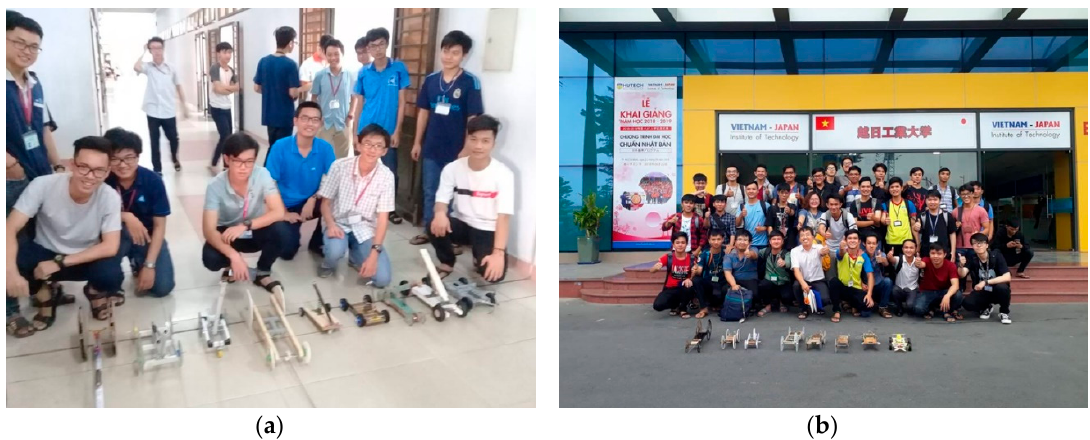
Figure 1. Mini-project of introduction to engineering class: ( a ) at HCMUT, and ( b ) at HUTECH.